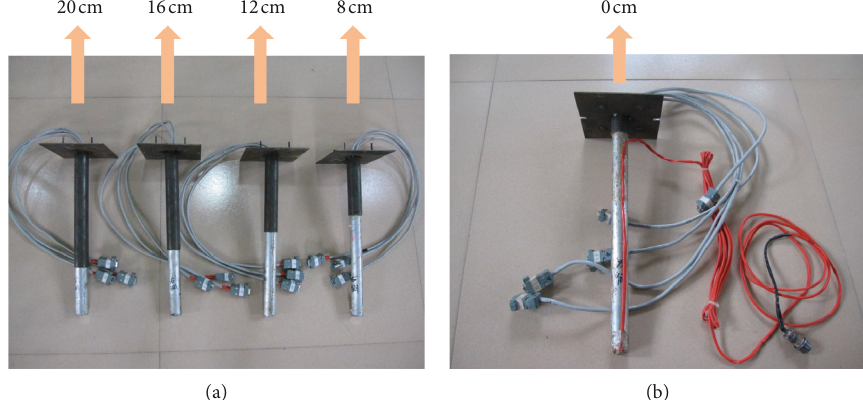
Figure 2: Photograph of the model piles. (a) Composite concrete-filled steel tube piles with different steel casing length. (b) Conventional reinforced concrete pile without steel